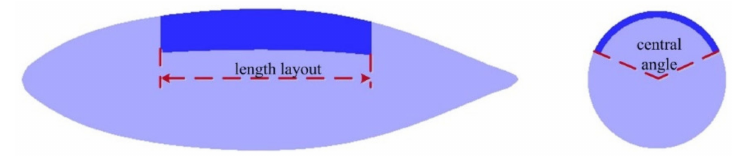
Figure 5. Schematic diagram of the solar array layout. Table 2. Energy generated by the solar array on the winter solstice. Energy (GJ) With Thermal Effect Energy (GJ) Central Angle and Area